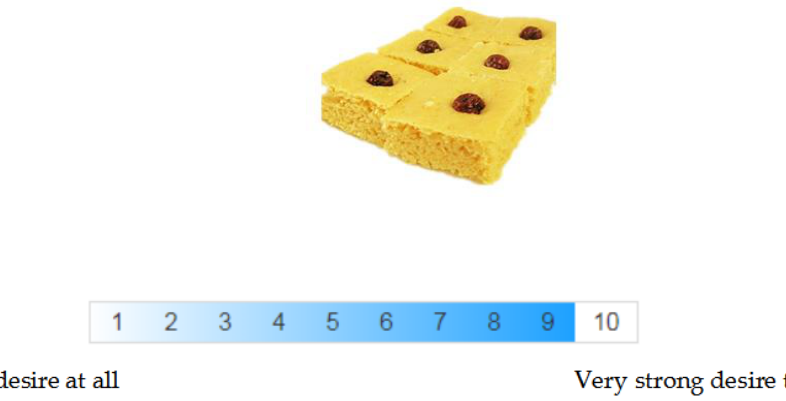
Figure A9. The picture of corn products (Solid food).